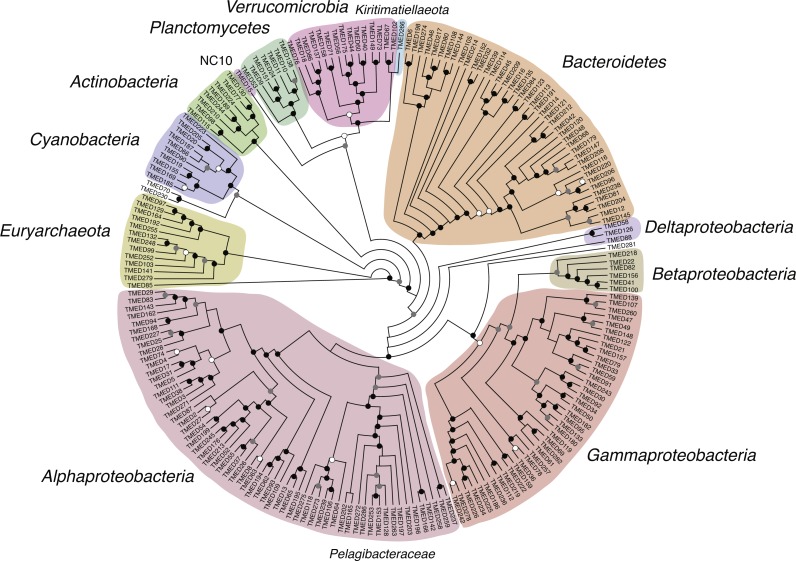
Cladogram of a FastTree approximate maximum-likelihood phylogenetic tree constructed using 16 syntenic, single-copy marker genes for 210 draft genomes.Support for internal nodes were determined based on the Shimodaira–Hasegawa test (white ≥0.500, gray ≥0.750, black ≥0.950). Sequence alignment for the draft genomes and the reference genomes used for phylogenetic assignment is available in Supplemental Information 7. Phylogenetic tree of the draft genomes and the reference genomes used for phylogenetic assignment is available in Newick format in Supplemental Information 8.